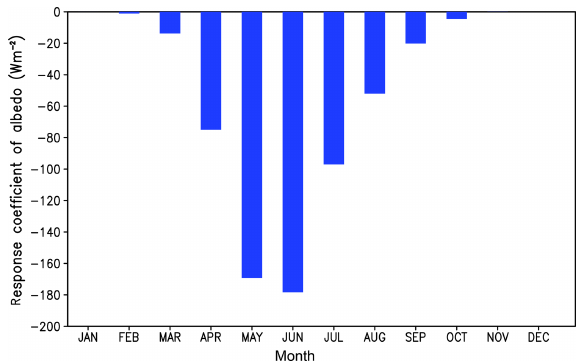
Figure 6. The monthly response coefficients (Wm − 2 ) of net short- wave flux to the albedo effect of sea ice.